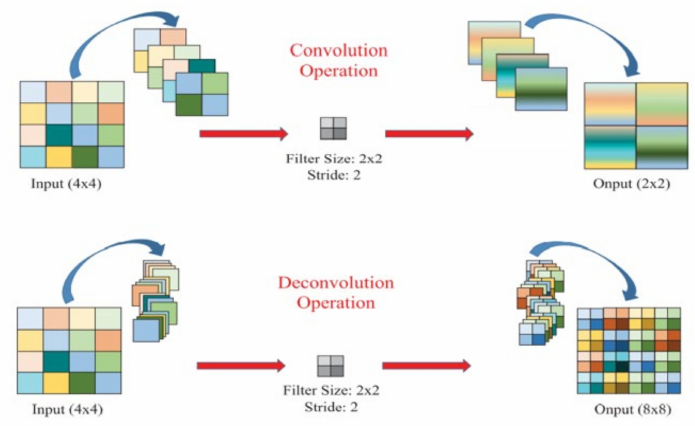
Figure 3. Illustration of convolution and deconvolution operations